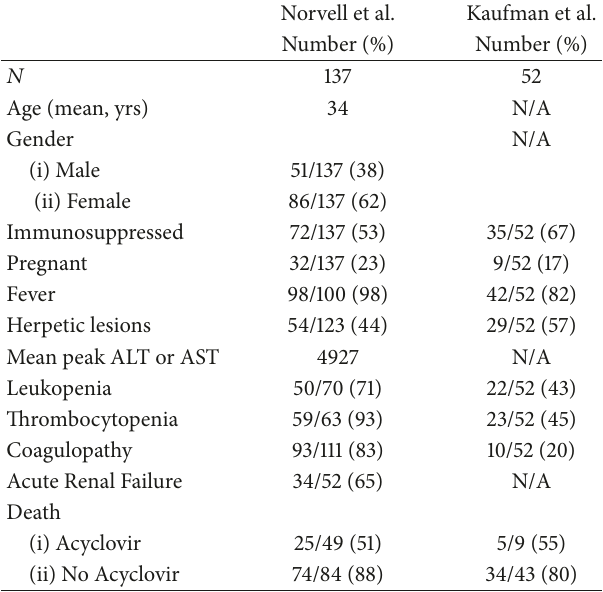
Table 2: Epidemiology based on two large literature reviews. Norvell et